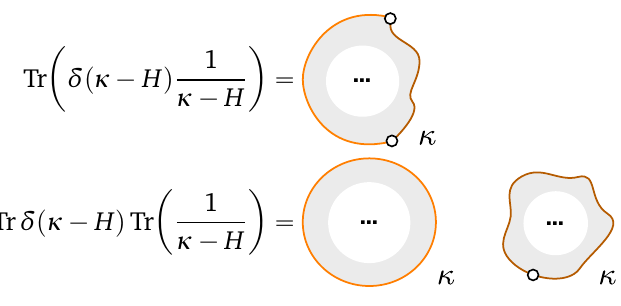
Figure 13: Contact terms correspond in gravity with different boundary conditions on different segments (left).The gravitational translation of the double trace operator (right) is inserting one boundary with fixed energy boundary state, and a marked FZZT boundary or resolvent [ 5, 107 ] . We distinguish these close related boundary states by picturing the FZZT boundary segments using dark orange wiggly curves in contrast to the eigenbrane boundary in